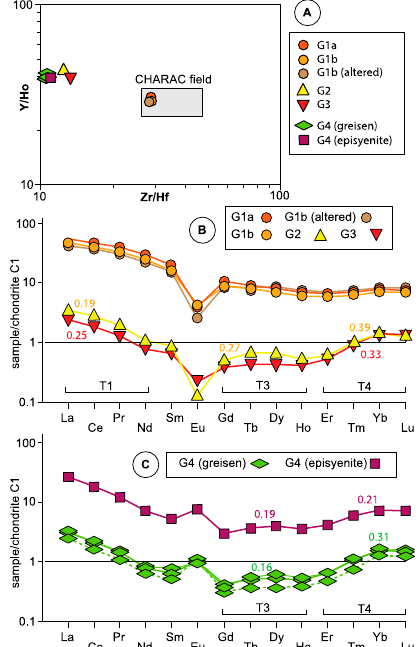
Figure 28. Patterns of RE variations (normalization to C1 chondrite [59]. Tetrad effect parameters Ti (i = I, II, III) are calculated following [60]; the effect is thought significant for Ti ≥ 0.2.